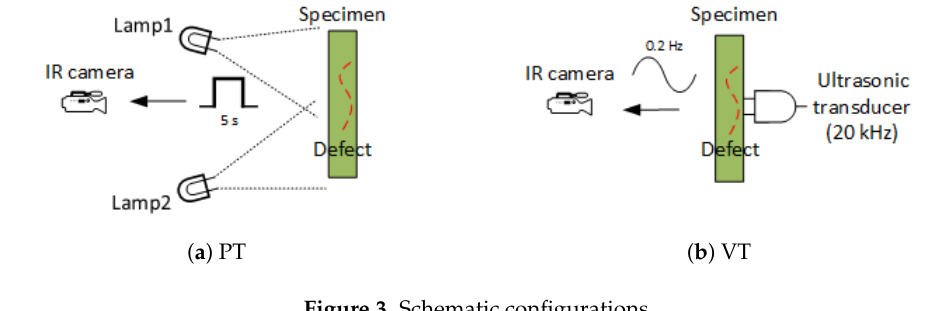
Figure 3. Schematic